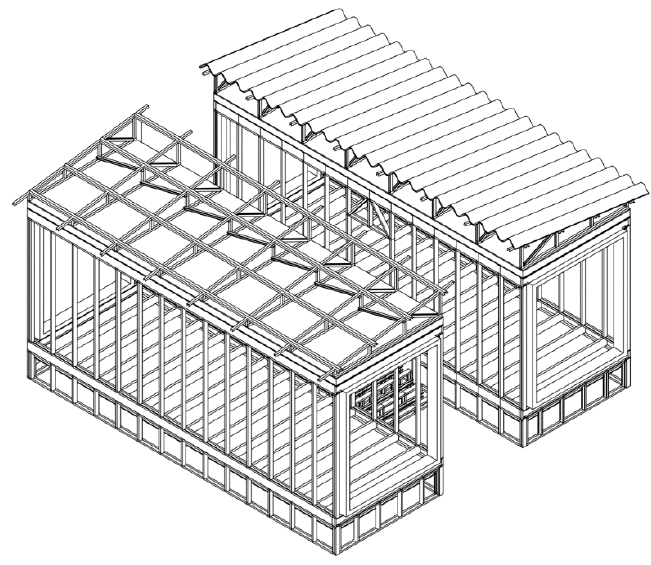
Figure 4. Axonometry of the module structure system, steel framing type.